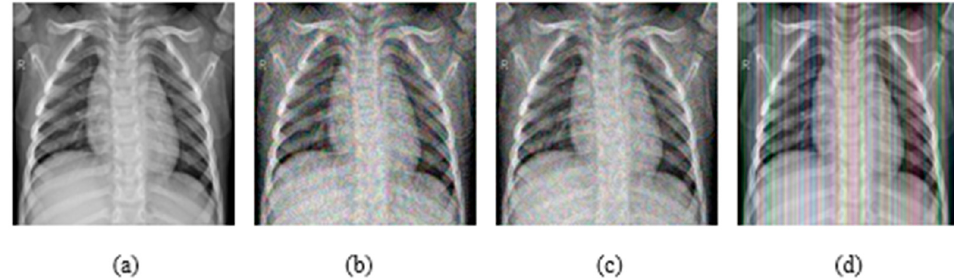
Figure 8. ( a ) Initial Image, ( b ) FGSM attack with ϵ = 0.15, ( c ) PGD attack with ϵ = 0.15, ( d ) Square Attack with ϵ = 0.15 .